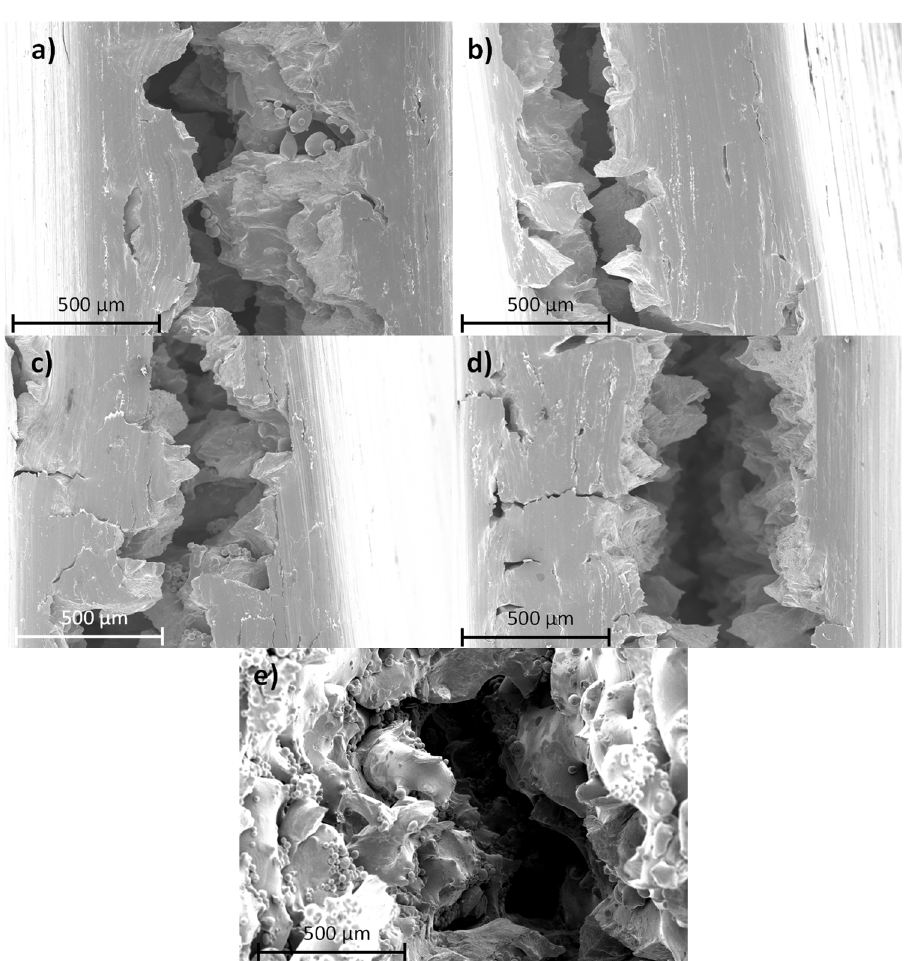
Figure 15. Fracture surfaces of CO 2 laser SLM samples: ( a ) XZ0; ( b ) XZ90; ( c ) YZ0; ( d ) YZ90; and ( e ) XY67.